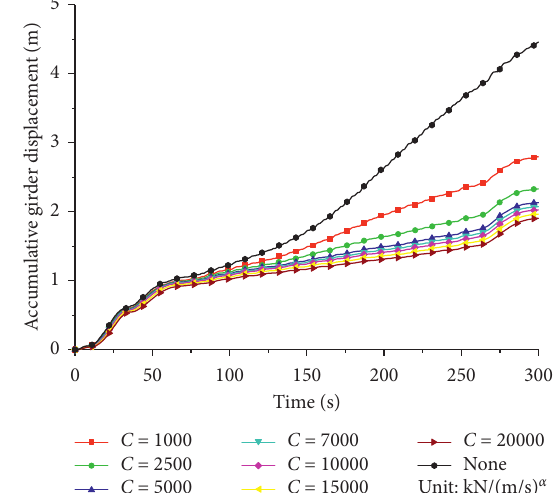
Figure 26: Time history curve of accumulative girder displacement ( α � 0 .